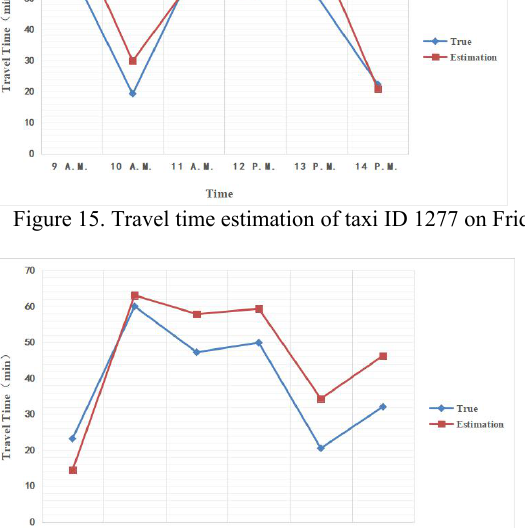
Figure 19. MAE and MRE at different time on